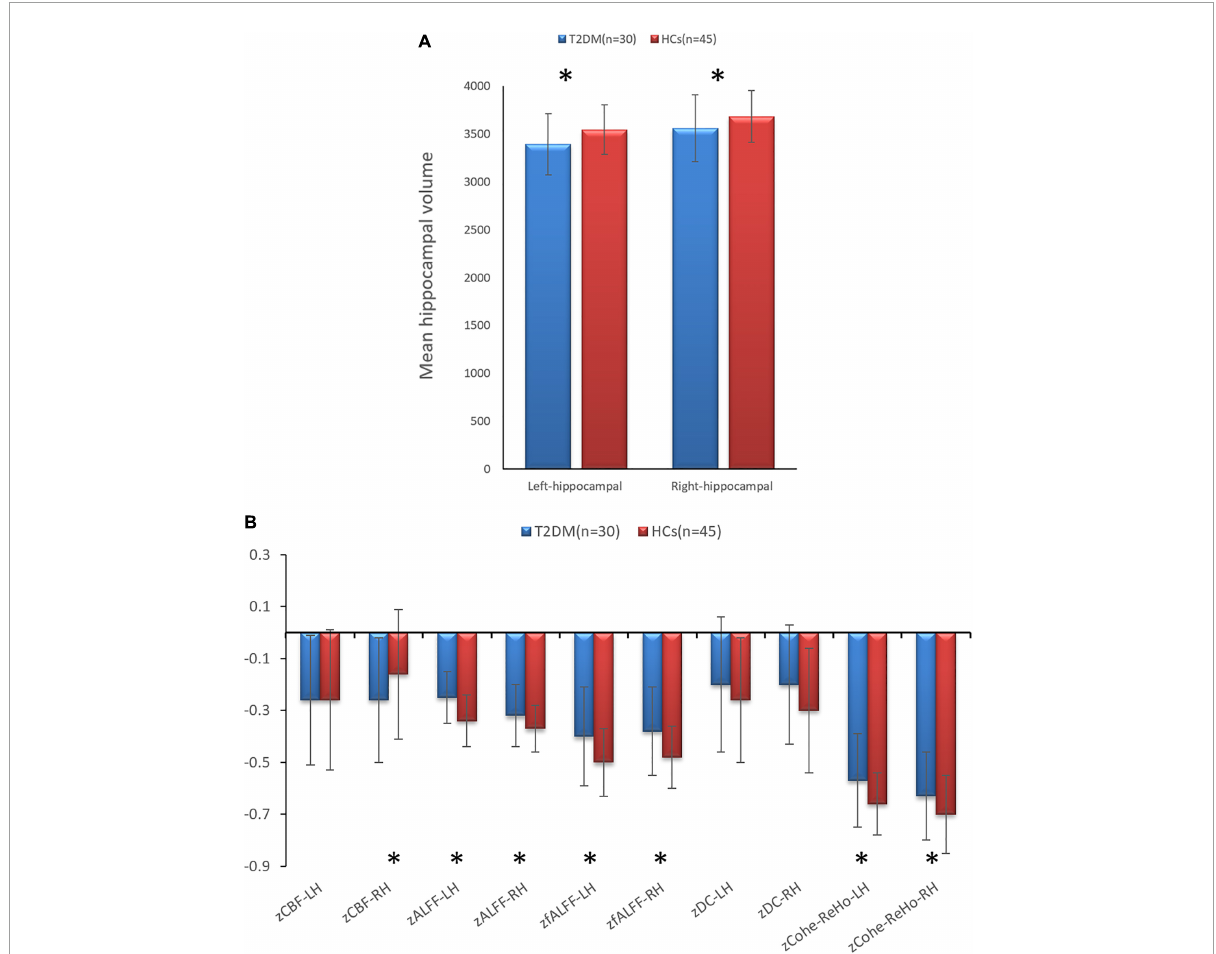
FIGURE1 (A) Comparison of the volumes of bilateral hippocampal between type 2 diabetes mellitus (T2DM) and healthy controls (HCs). (B) Comparison of the imaging indicators of bilateral hippocampal between T2DM and HCs. ∗ P <